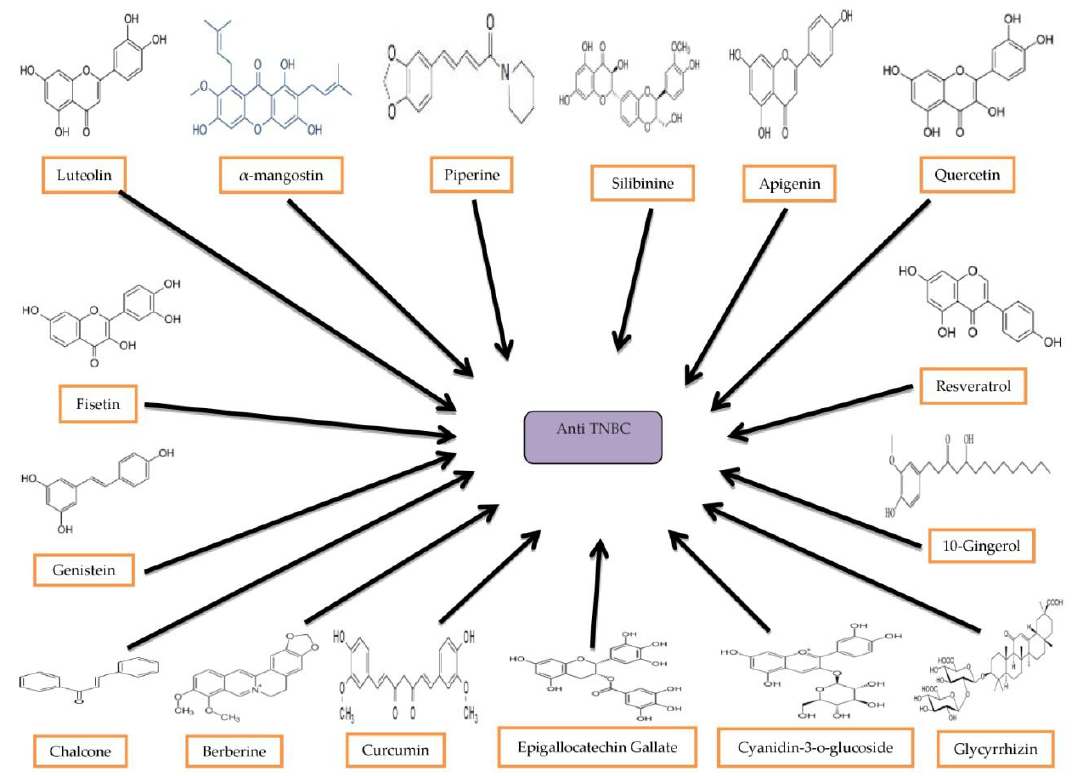
Figure 3. Bioactive compounds from different sources have shown anti-TNBC.